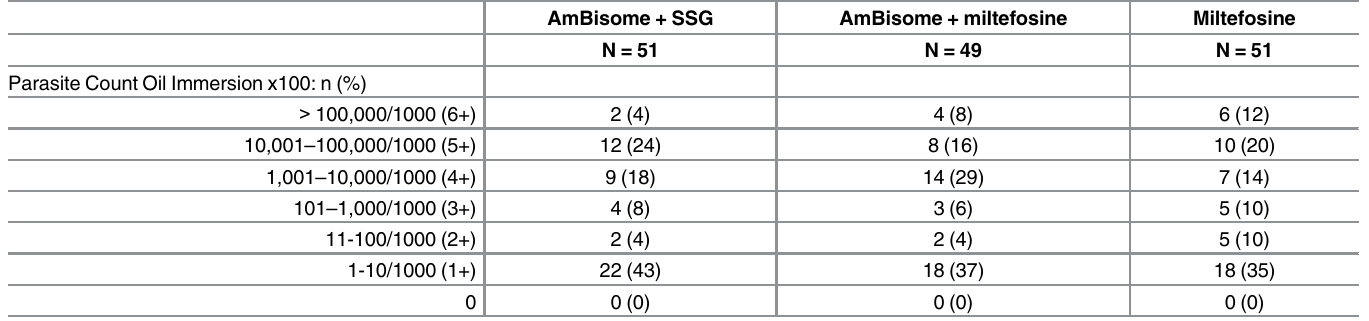
Table 3. Baseline parasite